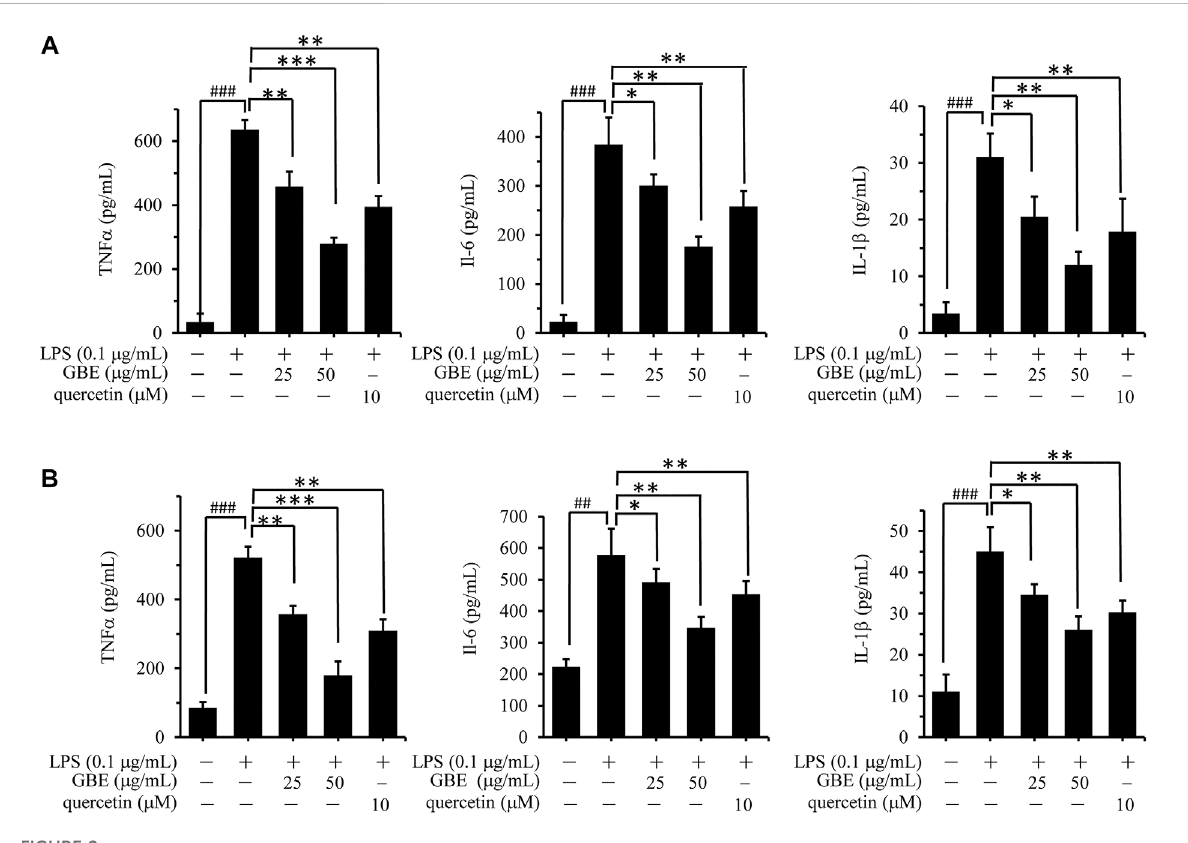
FIGURE 2 Effects of GBE on therelease of TNF- α , IL-1 β , and IL-6 inlipopolysaccharide (LPS)-activatedBV-2 microglia cells and U87 cells. BV-2microglial cells (A) and U87 cells (B) were pre-treated with GBE (25 and 50 µg/ml) or quercetin (10 µM) for 1 h, and then incubated with or without LPS (0.1 µg/ ml) for 24 h. After incubation, cell supernatants were collected and release of TNF- α , IL-6, and IL-1 β was measured using ELISA kit. The data are presented as the mean ± SD of three independent experiments. (* p < 0.05, ** p < 0.01, *** p < 0.001, GBE treatment vs. LPS-stimulated positive control; ### p < 0.001, LPS-stimulated positive control vs. vehicle control